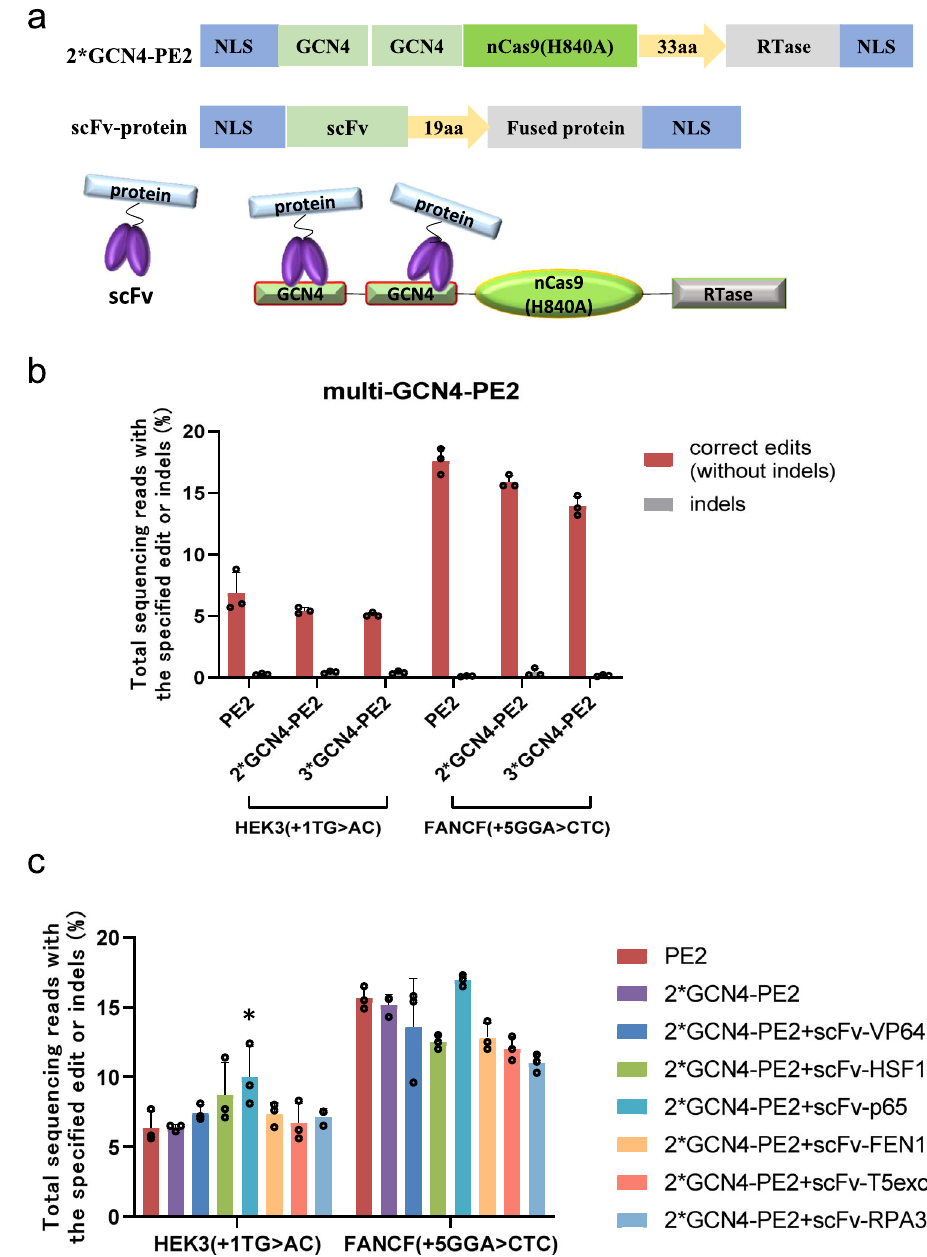
Fig. 1 | Adapting the Suntag system for screening of determinants of editing outcomes.a ConstructiondesignofSuntag-basedprimeeditingsystems. b Editing ef fi ciency of 2*GCN4-PE2 and 3*GCN4-PE2. Two or three copies of the GCN4 pep- tides were fused to the N-terminus of the nCas9 enzyme, and the resulting con- structswerenamed2*GCN4-PE2and3*GCN4-PE2,respectively.Atthetwogenomic loci ofHEK3 and FANCF, the editing ef fi ciencies induced by prime editorswith the increasedcopynumberofGCN4weredetermined.Thegraybarindicatestheindel frequencycoupled withtheediting ef fi ciencyindicatedbytheleftclosestbar.Bars